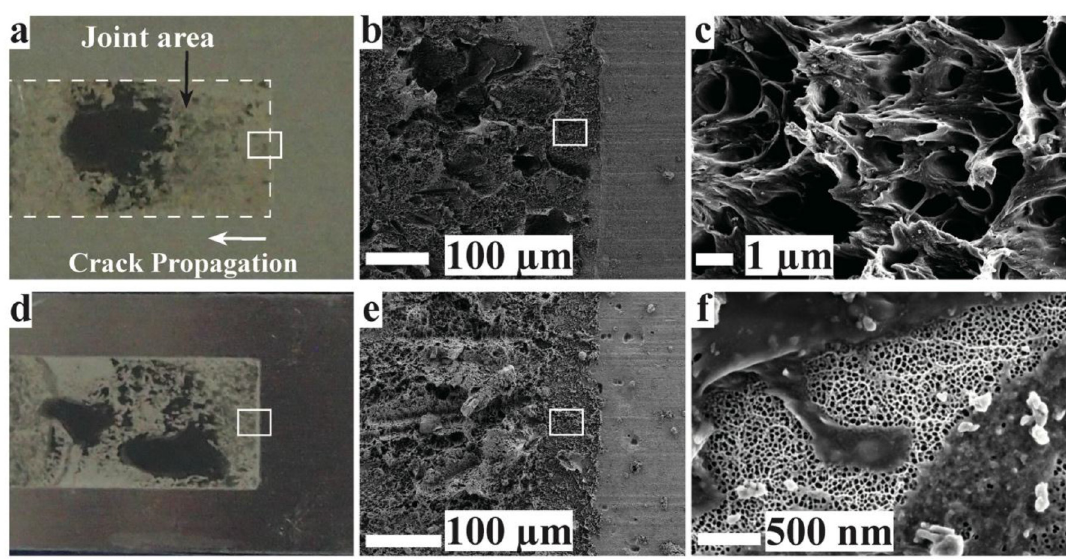
Fig. 14. Optical and SEM micrographs showing the fracture surfaces of Al5052 after fracture energy measurements. (a) – (c): NMT1 and (d) – (f): NMT2 surface treatments. (b) and (c) are SEM micrographs magnifying the regions indicated in (a) and (b), respectively. (e) and (f) are SEM micrographs magnifying the regions indicated in (d) and (e), respectively.